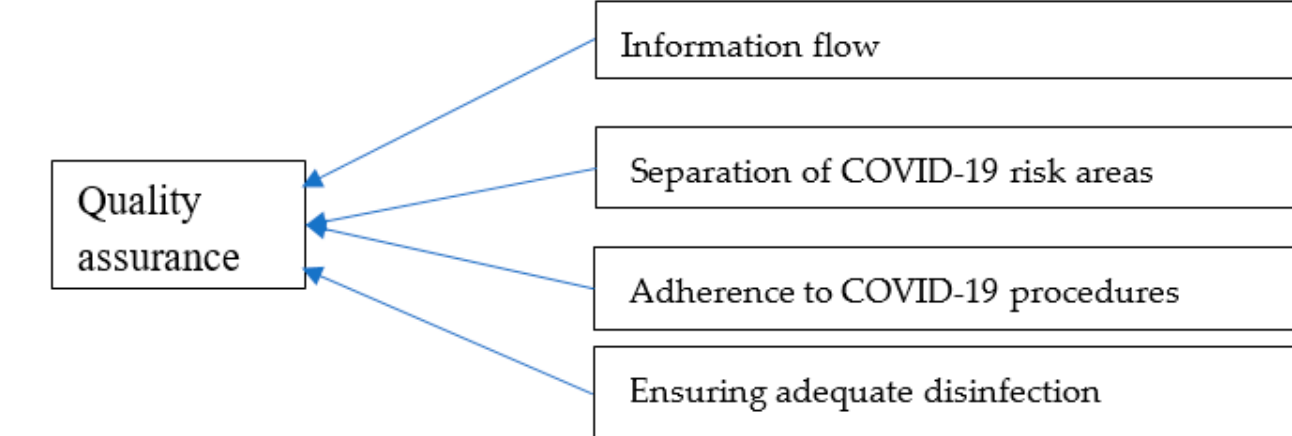
Figure 3. Clusters identified in quality assurance variables of health worker protection.